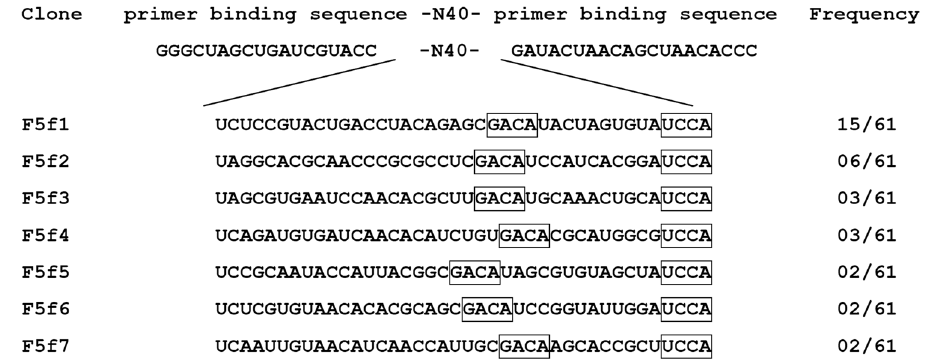
Figure 1. Sequence and frequency of the cloned aptamers. The selected sequences between primer binding sequences and their frequency among 61 clones are shown. The boxes indicate consensus